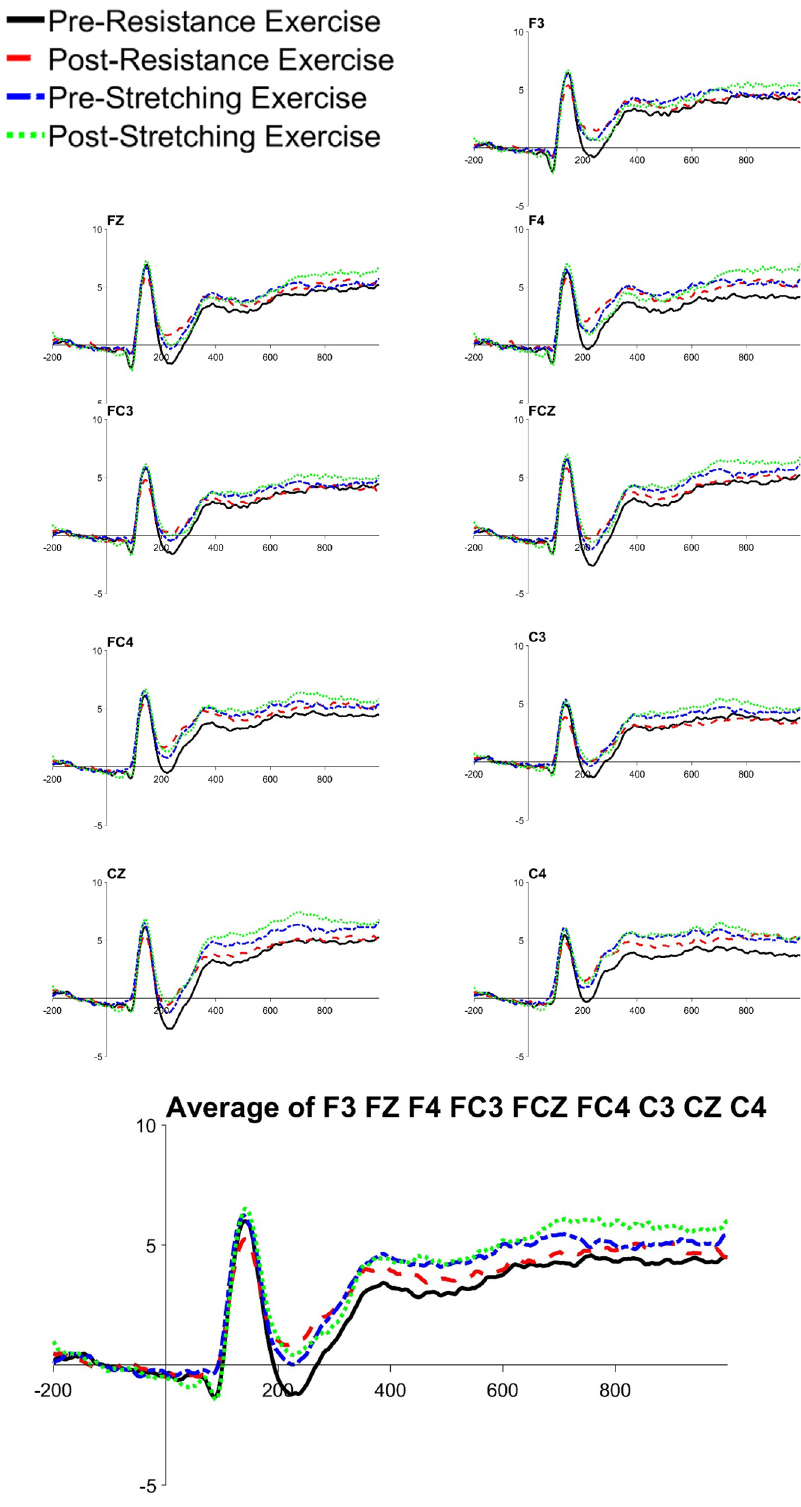
Figure 4. The grand averages of frontocentral electrodes in incongruent condition. Drawn by ERPlab 7.0 64